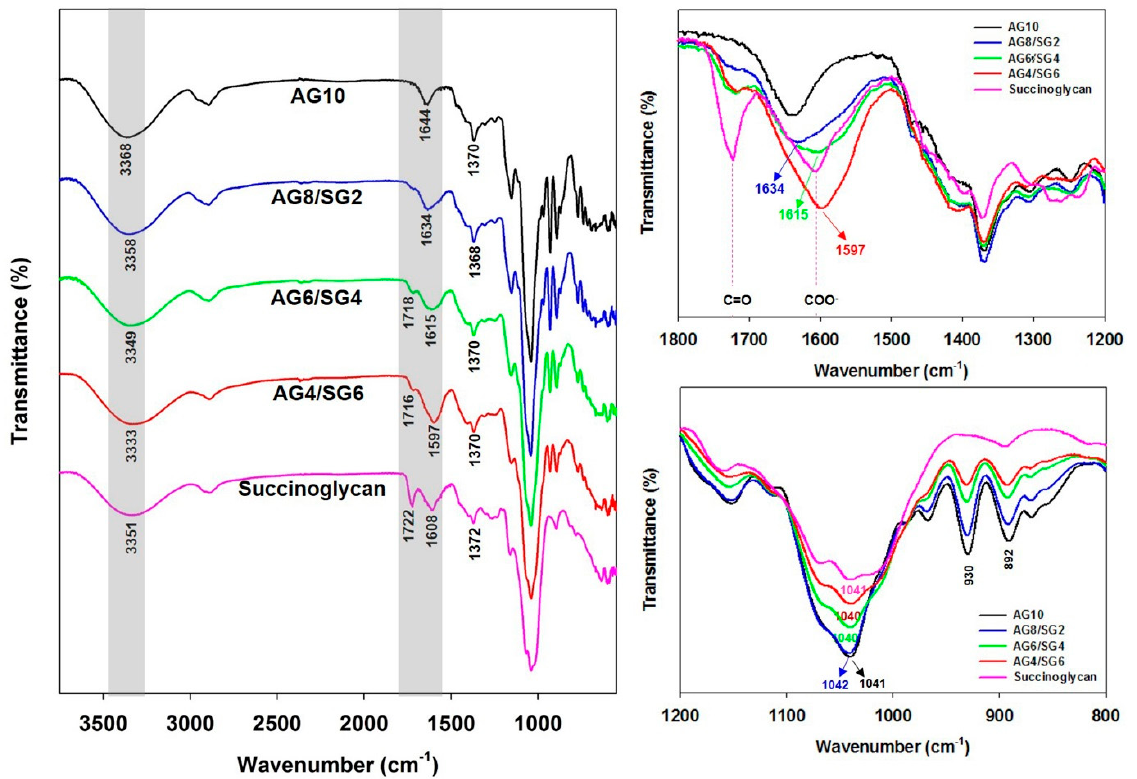
Figure 4. ATR-FTIR spectra of agarose/succinoglycan hydrogels and pure succinoglycan.